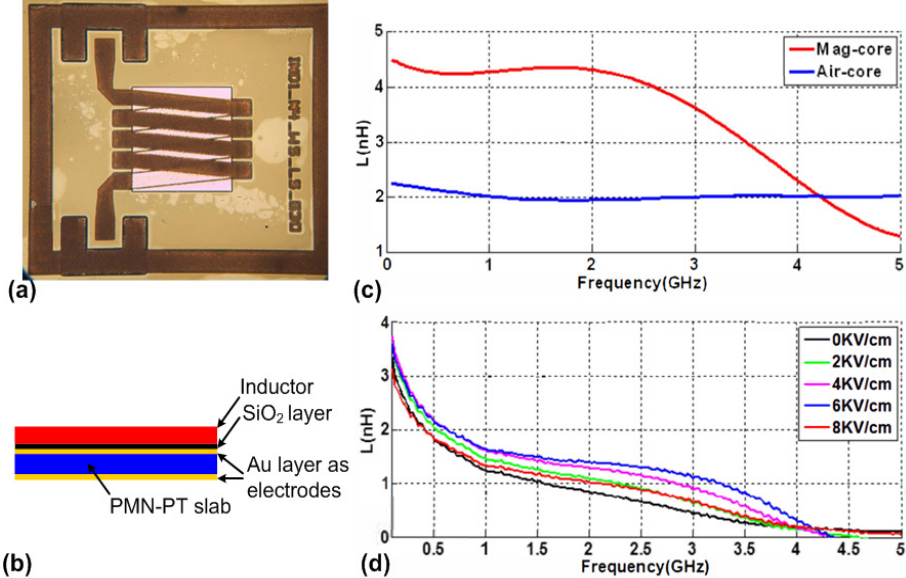
Figure 11. ( a ) Optical image of the tunable inductor; ( b ) schematic of the layered structure of the tunable inductor; ( c ) measured inductances of the inductor with magnetic multilayer films as the inductor core and the one with air core; and ( d ) measured inductance under different E-field applied across the thickness of the PMN-PT slab. This figure is reproduced from [138] and [139] (© 2014 IEEE).